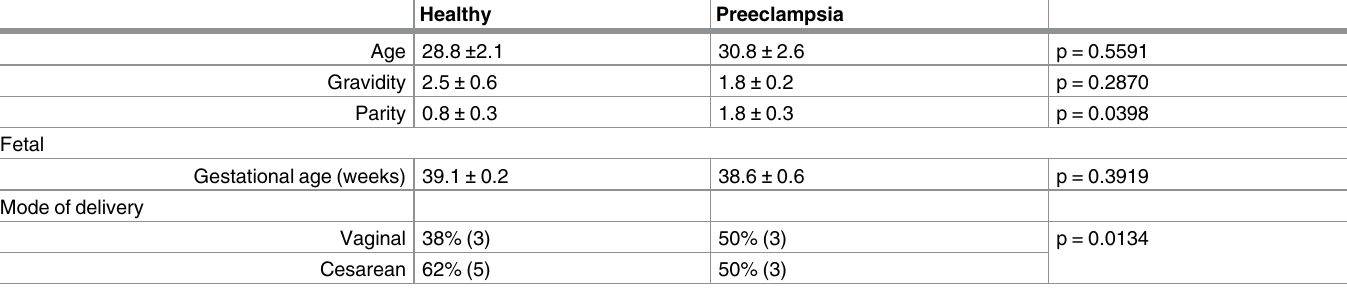
Table 3. Subject characteristics for Treg tolerance defect in preeclampsia. Age, gravidity, parity, and gestational age differencesanalyzedwith a two- way student’s T test. Mode of delivery differences analyzedusing a Fisher’s exact test.